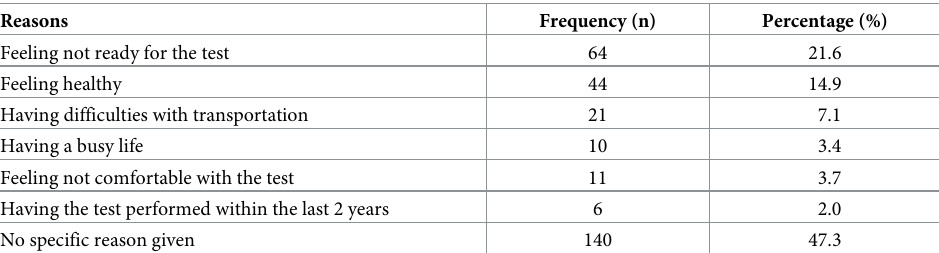
Table 3. Reasons for refusal of the iFOBT (n =